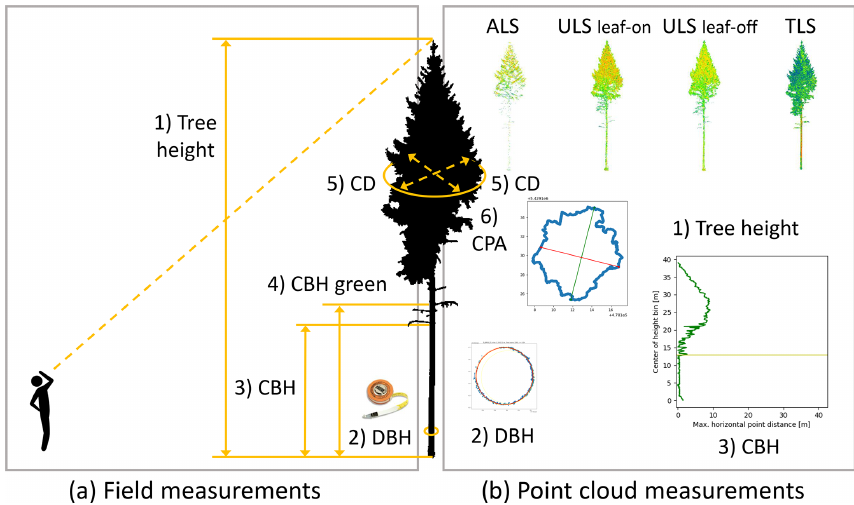
Figure 6. Overview of single tree measurements (a) recorded in the field and (b) derived from the point clouds. Numbers correspond to Table 3. Icon on the left (“man looking up”) by DonBLC, https://thenounproject.com/ (last access: 3 August 2021). Picture of diameter tape from https://www.forestry-suppliers.com/ (last access: 3 August 2021).